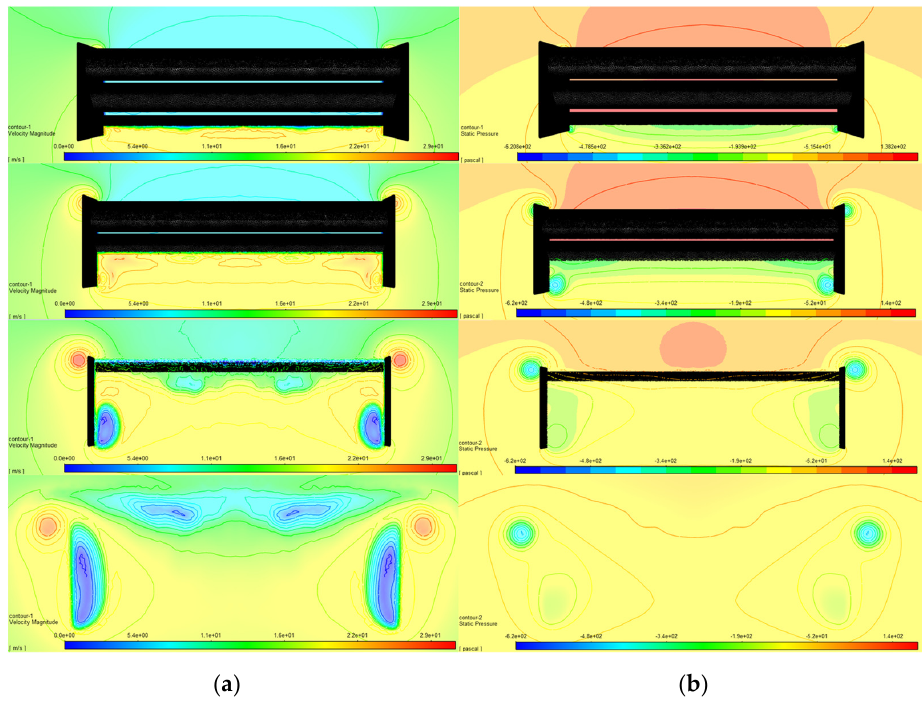
Figure 8. ( a ) Speed contour and ( b ) pressure contour for the multi-element wing. From top to bottom, different sections of the rear wing are represented.